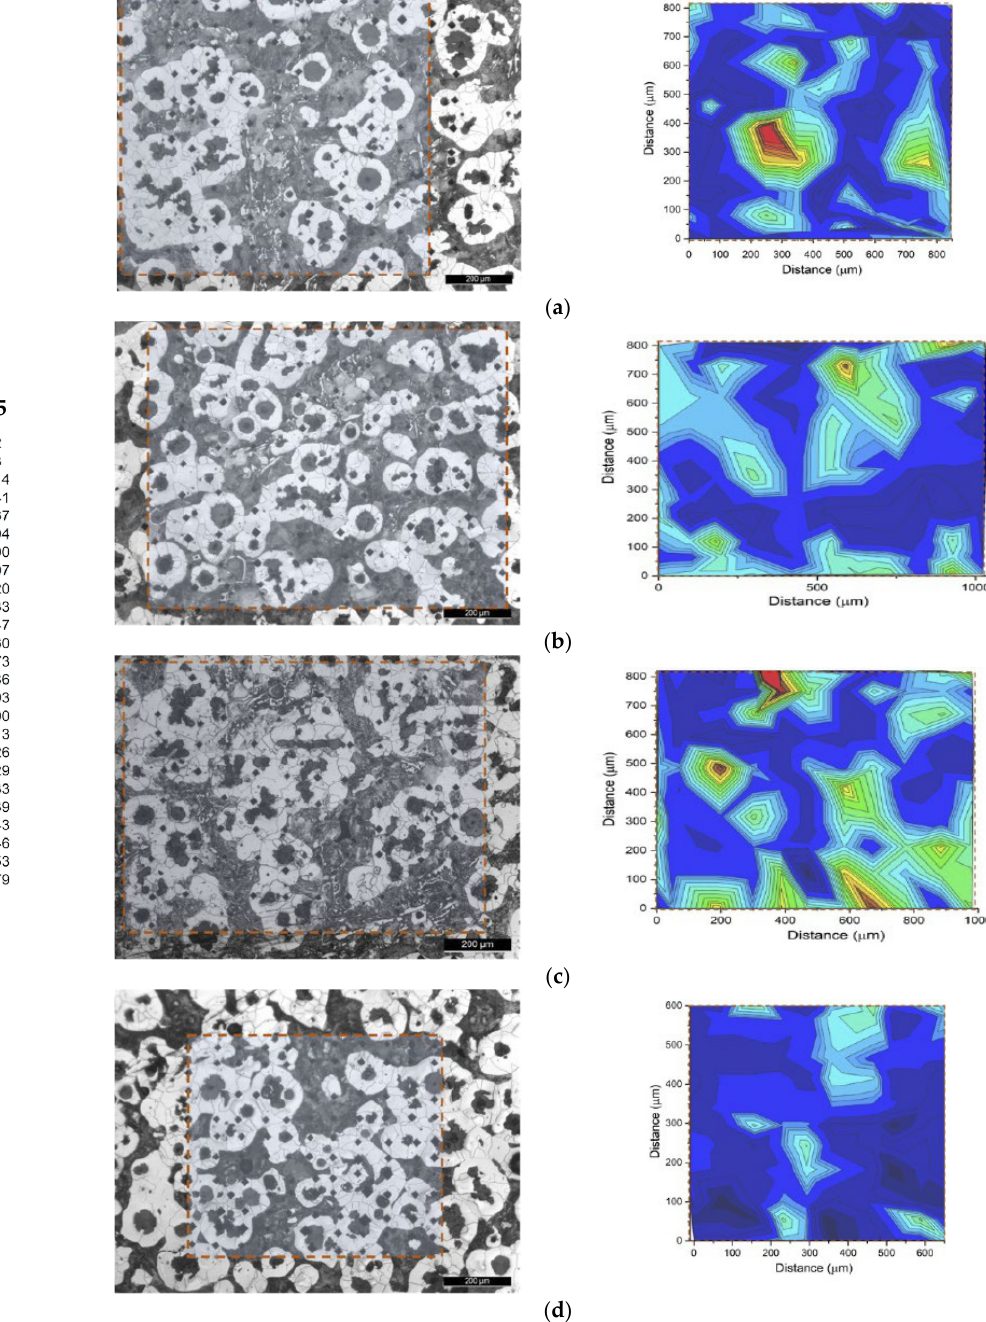
Figure 13. OM image and hardness distribution maps of the samples: ( a ) noP Un , ( b ) CP Un , ( c ) LCP Un , and ( d ) TP Un .